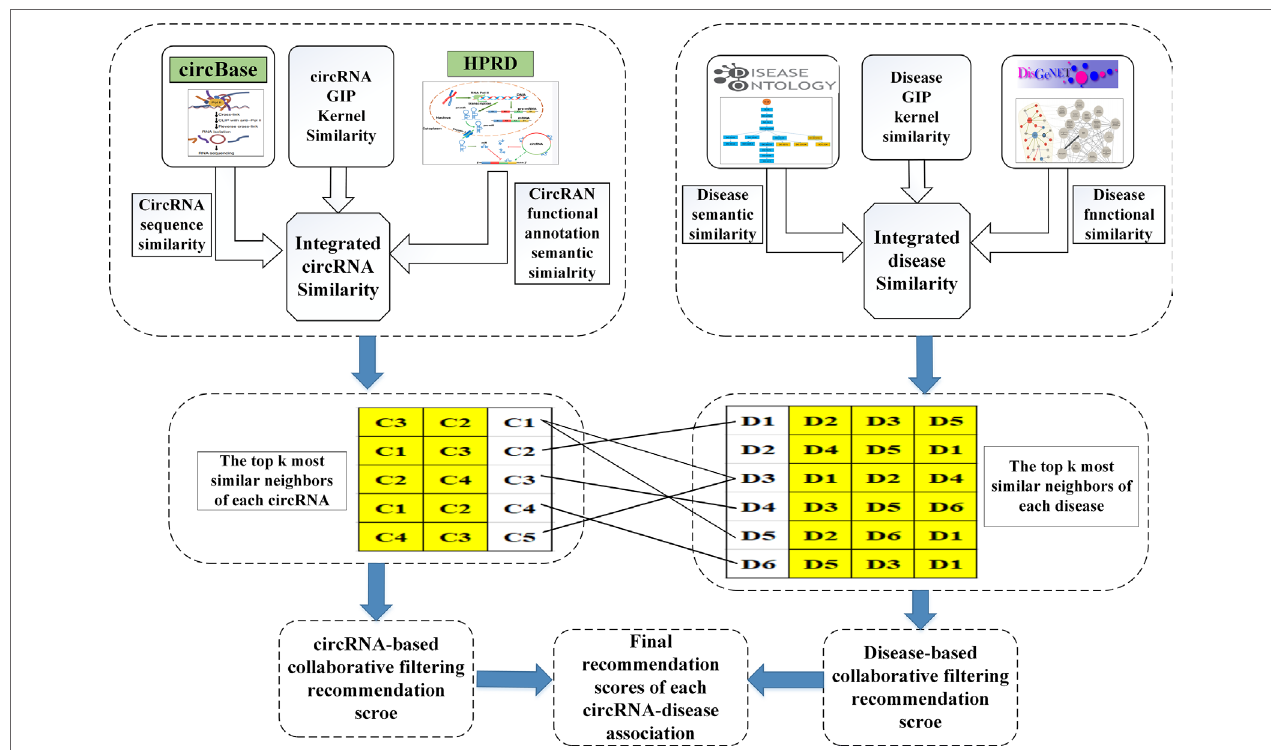
FIGURE 1 | The flowchart of the computational method